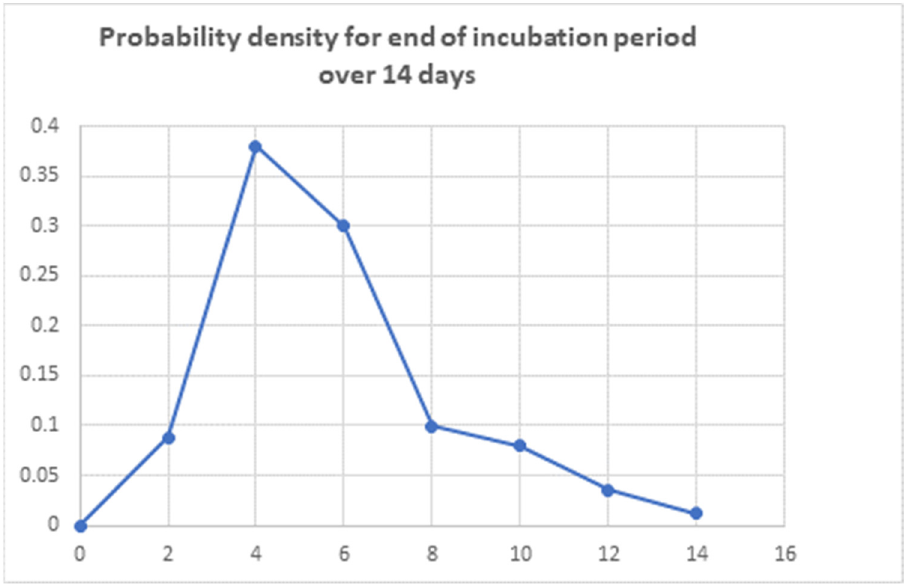
Figure A1. Probability density for end of incubation period over 14